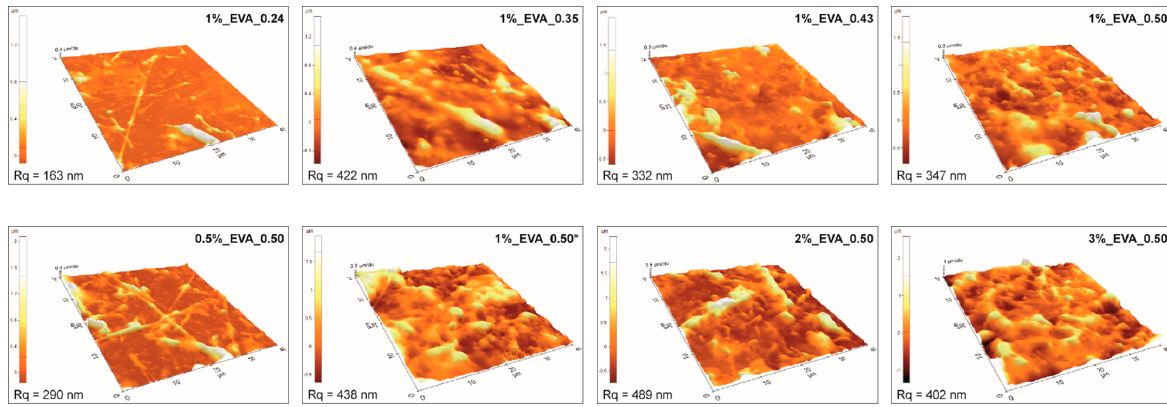
Figure 2. AFM images of two series of EVA coatings with root mean square roughness (R q ).